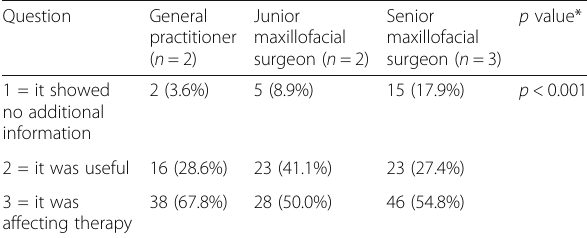
Table 5 Results of the question “ Is there an additional clinical value of sFOV-CBCT?